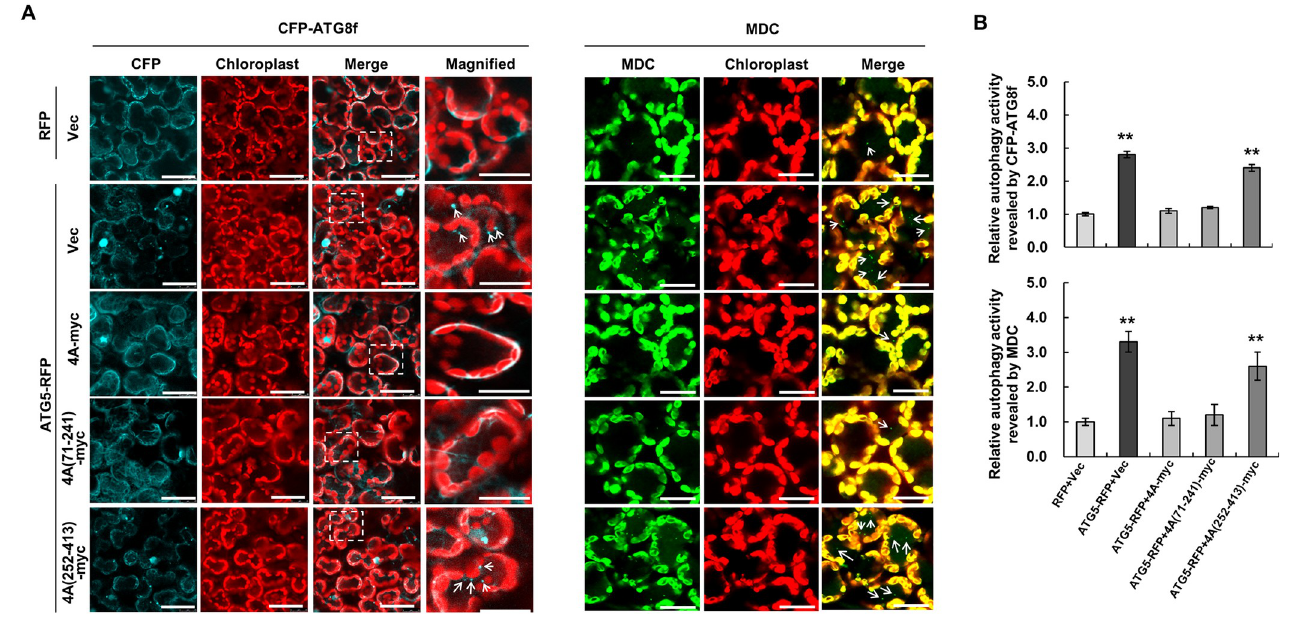
Fig 5. Expression of NbeIF4A suppresses NbATG5-activated autophagy. (A) Representative confocal images of autophagic activity revealed by the autophagy marker CFP- Nb ATG8f or MDC staining. RFP or ATG5-RFP was co-expressed with 4A-myc, 4A(71–241)-myc, 4A(252–413)-myc, and empty vector (Vec) in N . benthamiana leaves by Agrobacterium-mediated infiltration. Cyan: CFP-ATG8f signal; green: MDC-stained structures; red: chlorophyll autofluorescence. Bars, 20 μ m. Magnified area is indicated by a white dashed box. (B) Relative autophagic activity, normalized to that of cells expressing RFP and empty vector, which was set to 1.0. Quantification of CFP-ATG8f-labeled or MDC-stained autophagic foci per cell was performed by counting autophagic bodies to calculate the autophagic activity. Over 150 cells per treatment were used for quantification. Error bars indicate standard error from three individual experiments. Asterisks indicate significant differences by Student’s t -test compared to control cells expressing RFP and Vec ( �� , p < 0.01). (C) Immunoblot analysis of the accumulation of proteins examined in this experiment.